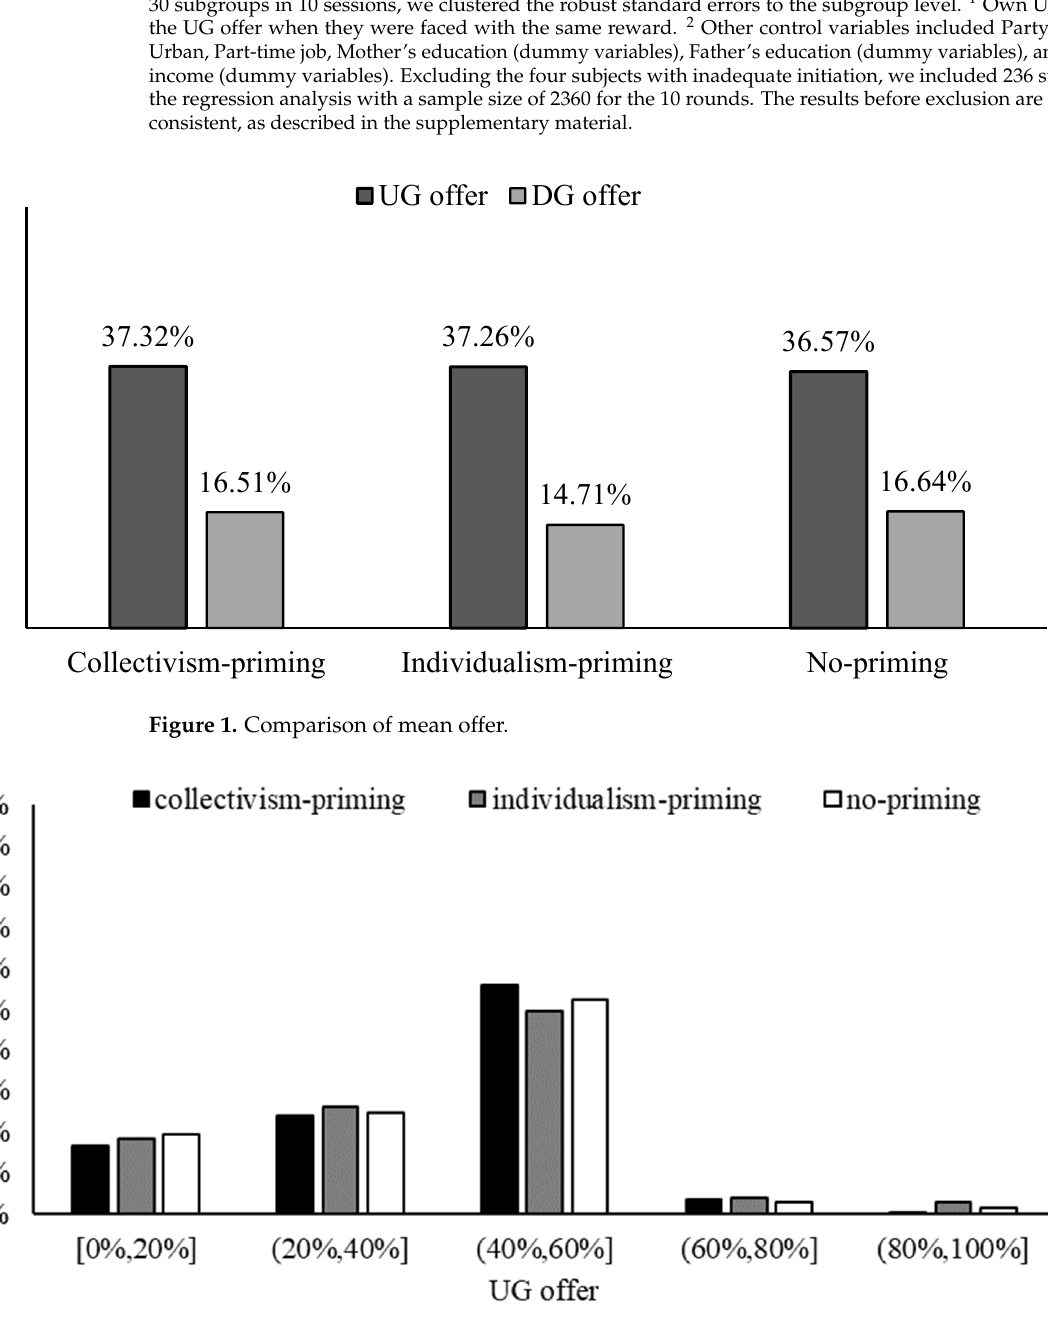
Figure 2. Frequency of UG offers.